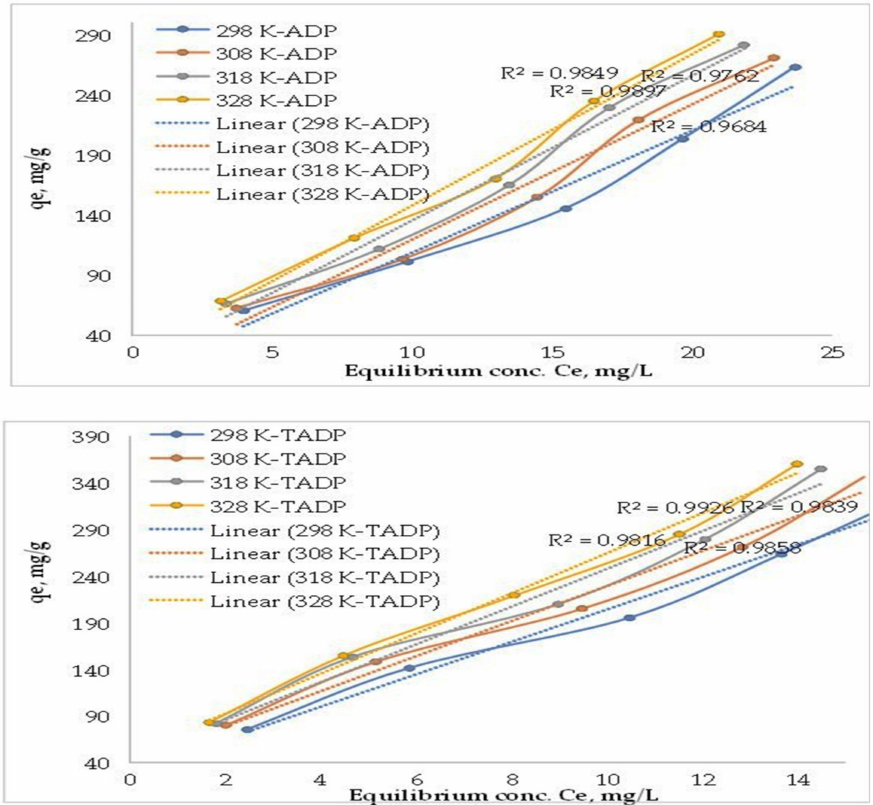
Figure 7. Effect of initial metal concentration and temperature (experimental conditions: initial conc: 25 mg/L; adsorbent weight: 0.005 g; volume: 0.05 L; temperature: 25 ◦ C; contact time: 5 h; shaker speed: 100